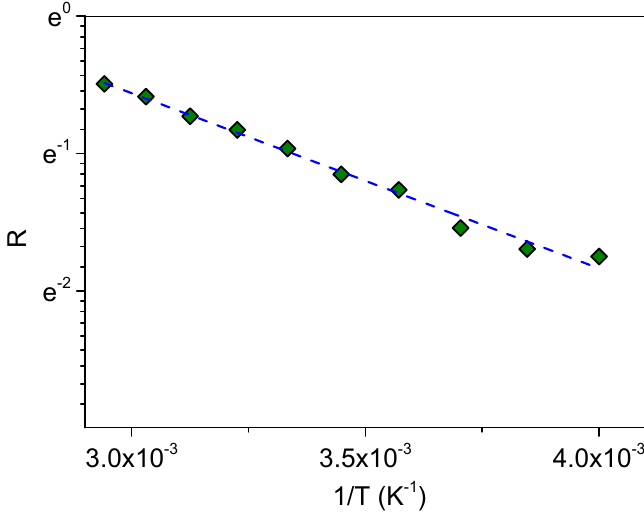
Figure 6. Semi-log plot of the temperature dependence of R .